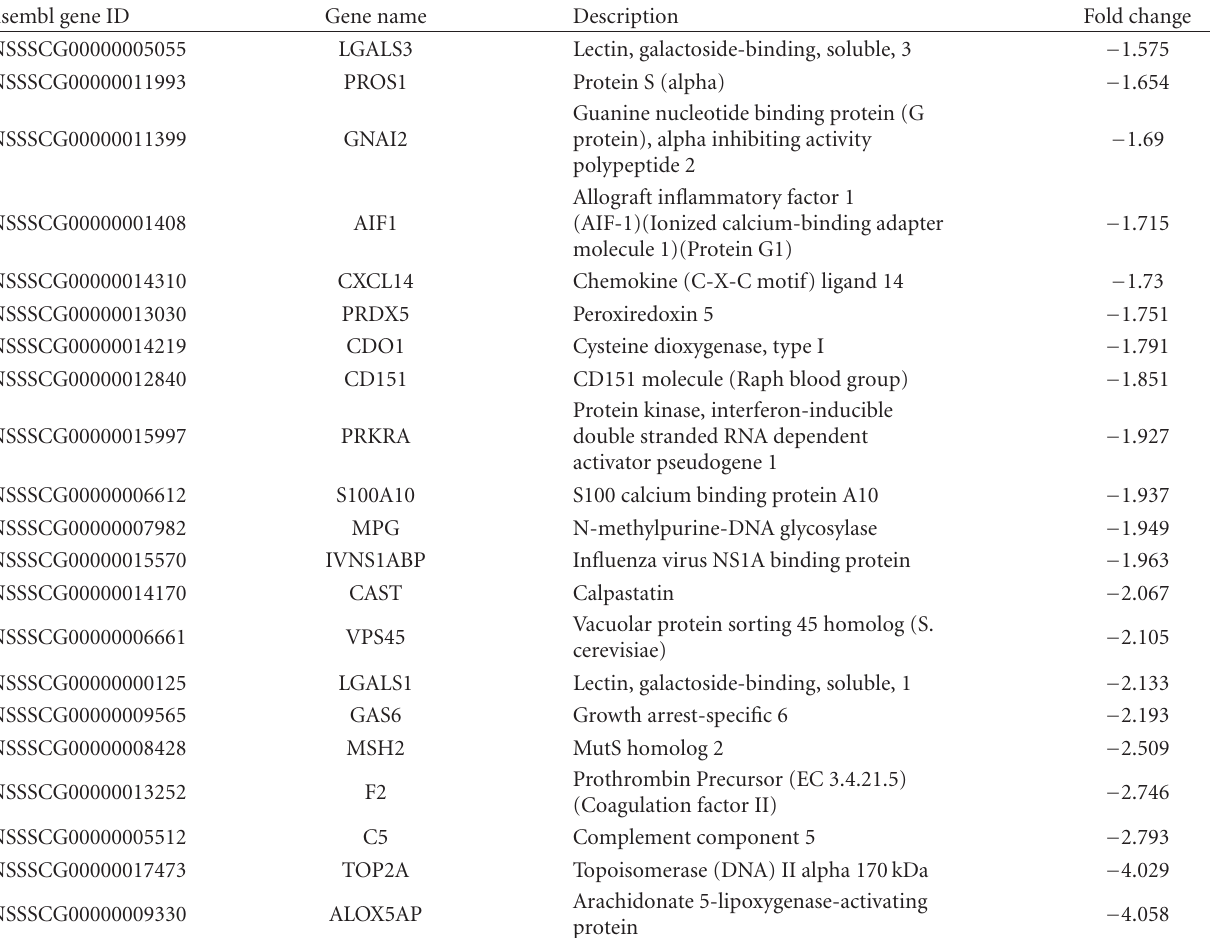
Table 3: Down regulated genes related to inflammation. All genes had a P ≤ 0 .